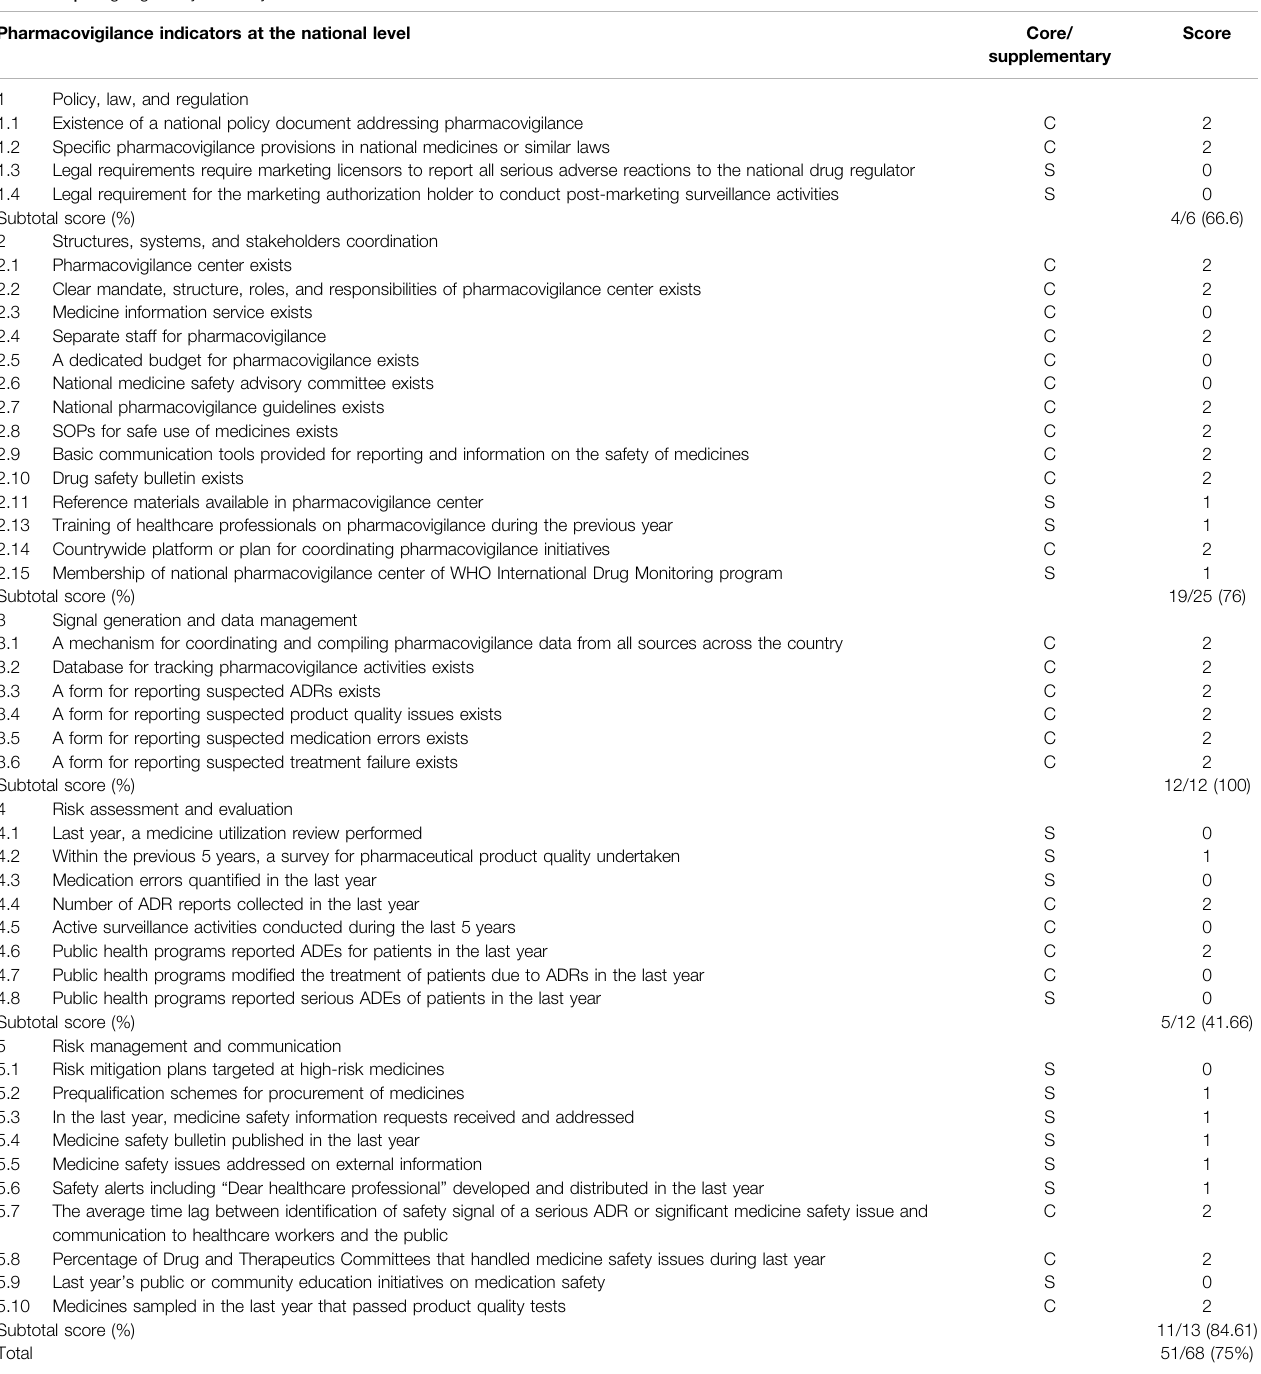
TABLE 1 | Drug regulatory authority of Pakistan. Pharmacovigilance indicators at the national